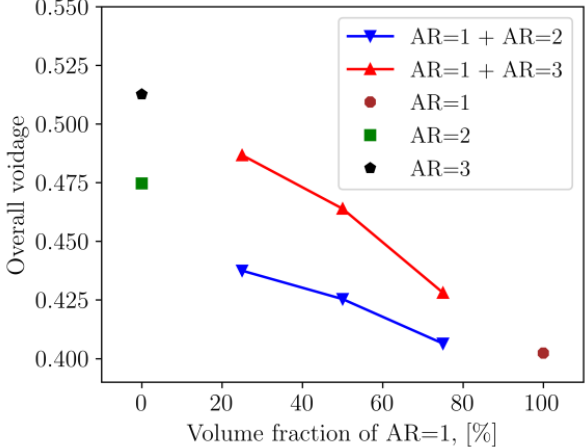
Figure 2. Overall voidage of binary mixture of cylindrical particles.